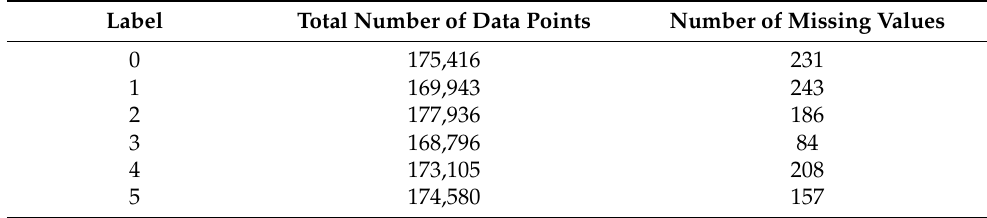
Table 4. Description of missing values in the material dataset.